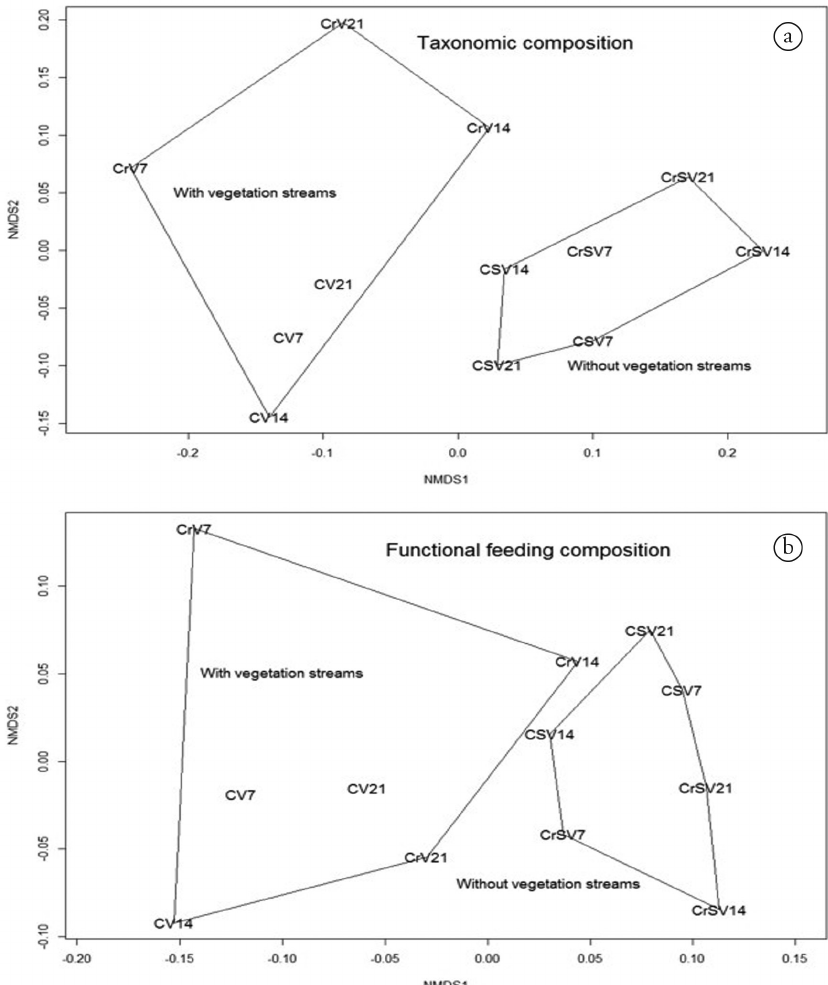
Figure 3. NMDS ordination of (a) taxonomic and (b) functional invertebrate fauna composition associated in Campomanesia xanthocarpa leaf litter in the streams in the Campo river hydrographic sub-basin and Cravo river hydrographic sub-basin, Southern